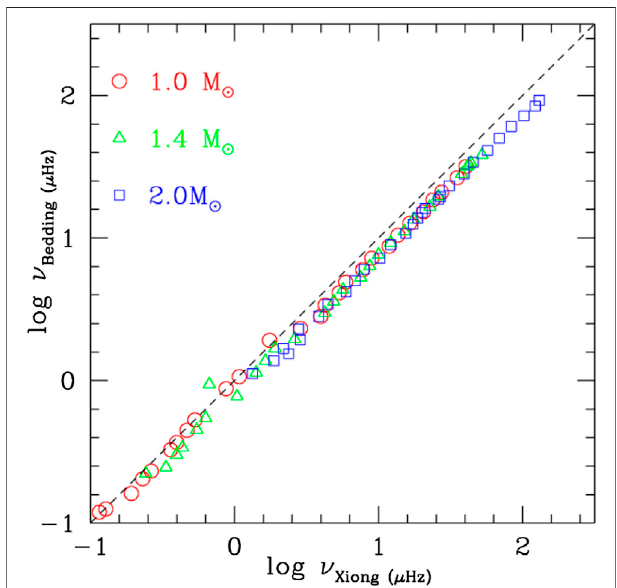
FIGURE 10 | Comparison of our theoretical prediction of the maximally unstable mode based on pulsation calculations (abscissa) with the semi- empirical scaling relation (ordinate) for the p-mode peak of stochastically excited modes (Kjeldsen and Bedding,